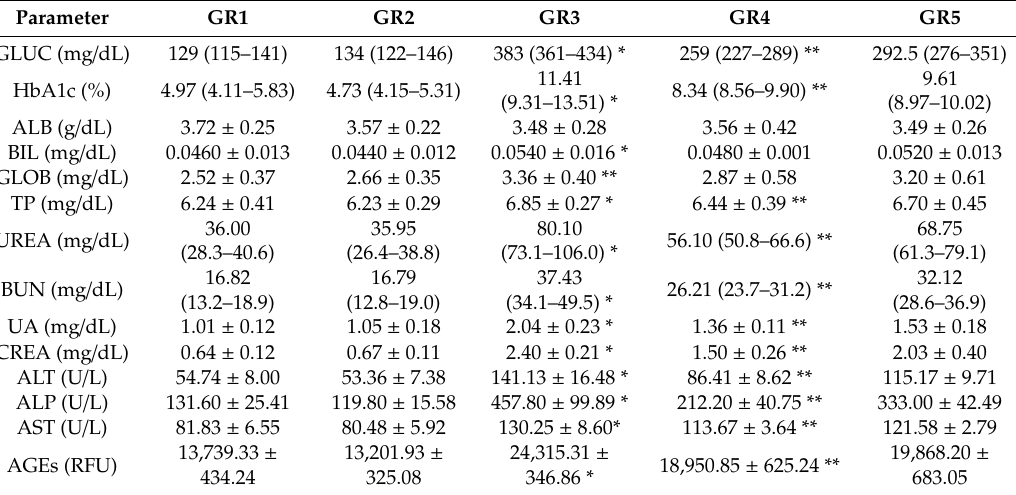
Table 3. The results of the clinical biochemistry analysis.